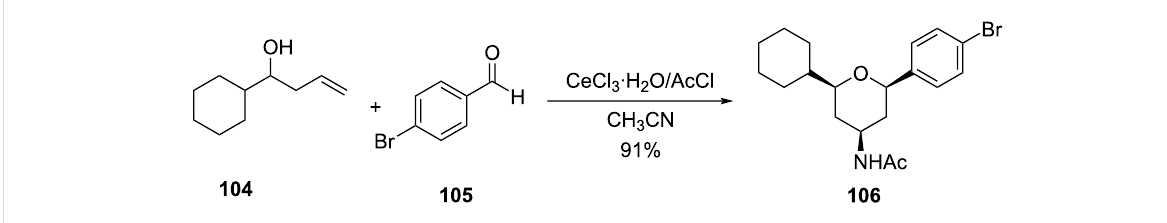
Yadav’s group reported the synthesis of 4-iodotetrahydropy- rans (dr = 7.5:2.5) from aromatic aldehyde 111 and homoallylic alcohol 110 using TMSCl and NaI. Furthermore, the major